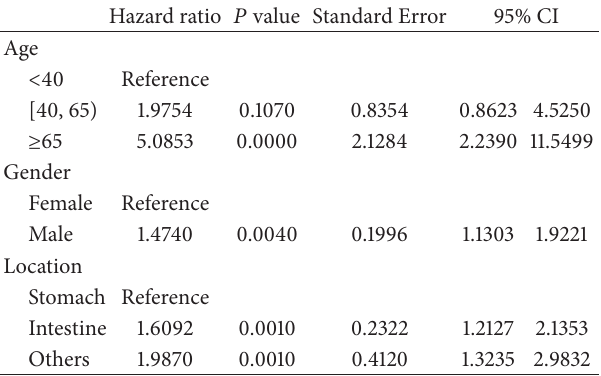
Table 4: Cox proportional hazards model with multivariate analy-